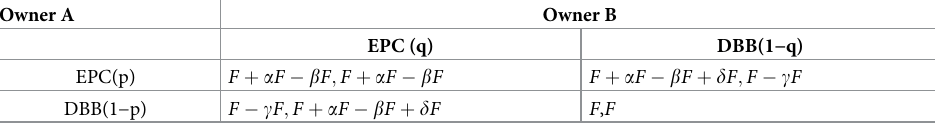
Table 1. Payoff matrix of project Owner A-Owner